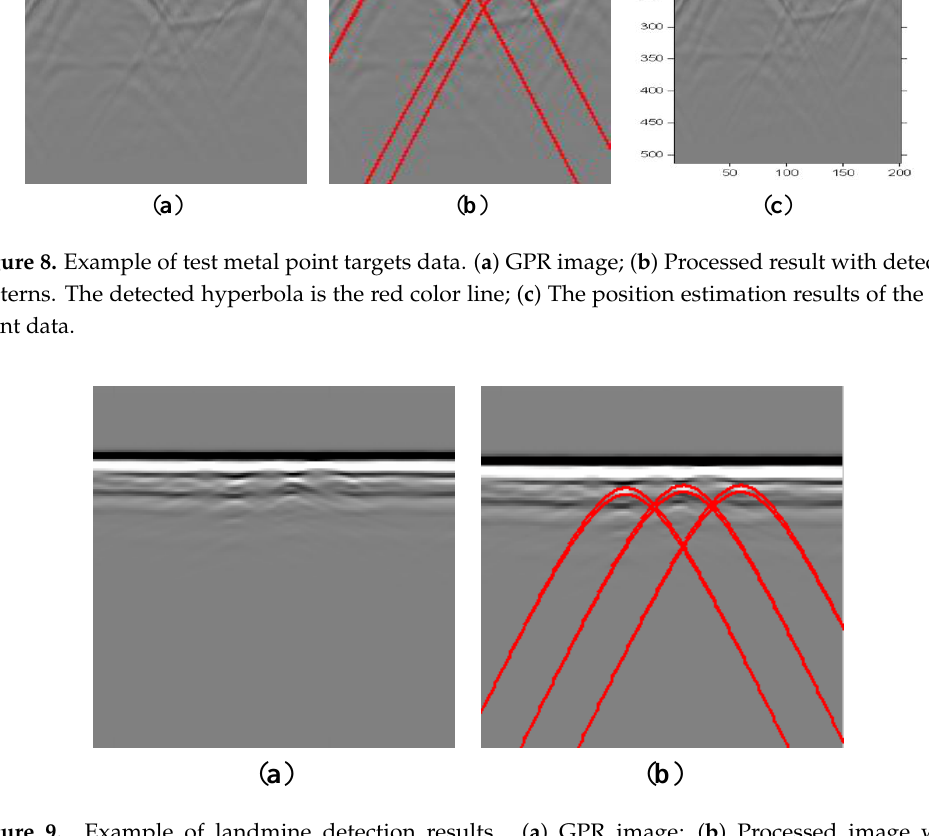
Figure 9. Example of landmine detection results. ( a ) GPR image; ( b ) Processed image with detected patterns.